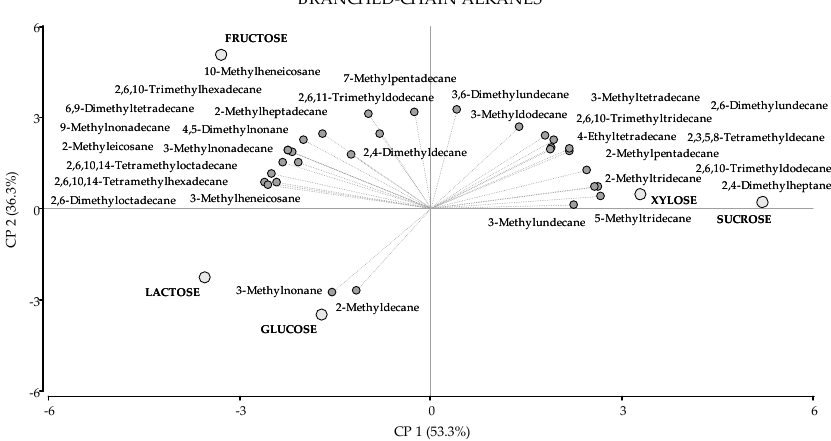
Figure 1. PCA of Branched-chain alkanes. A total of 35 variables were included: 30 VOCs (dark grey circles) and 5 carbon sources (light grey circles). The first two principal components accounted for 53.3% and 36.3% of the total variation, respectively.